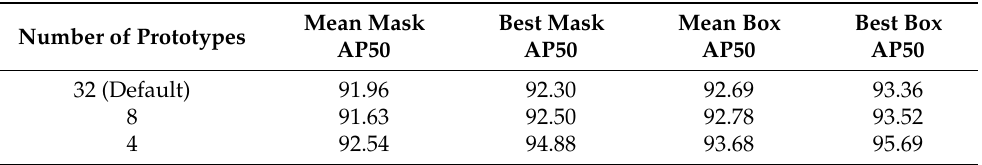
Table 6. Performances of models under different prototype settings.